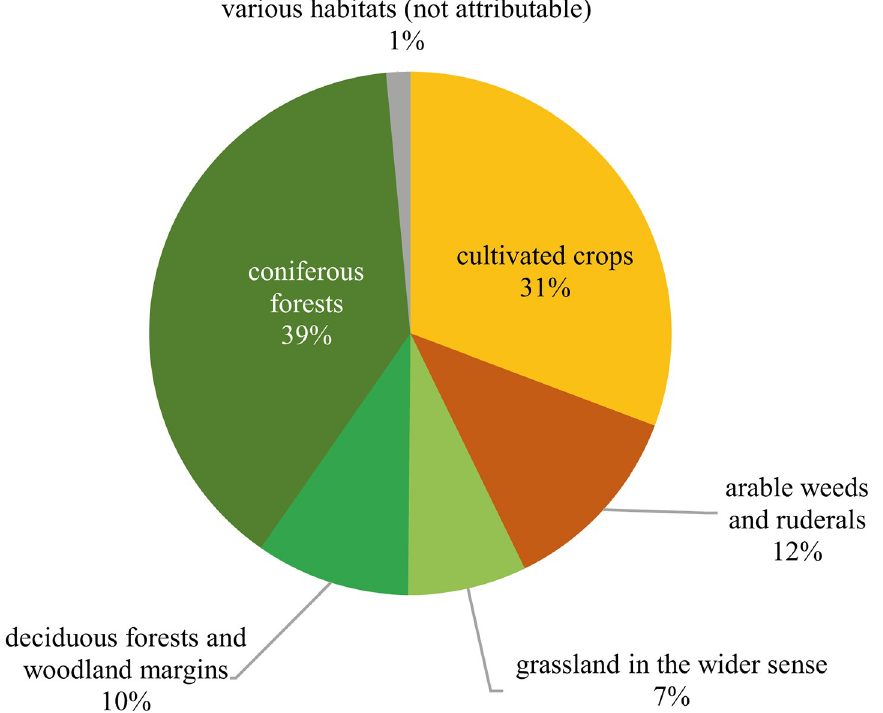
Fig 11. Identifiable plant macroremains from Late Bronze Age Prigglitz-Gasteil, assigned to ecogroups. The group “deciduous forests and woodland margins” overlaps to a large extent with the “wild fruits” group from Fig 10. The group “coniferous forests” is mainly represented by fir and spruce needles. n = 3,630. Diagram: OeAW-OeAI/T. Jakobitsch.